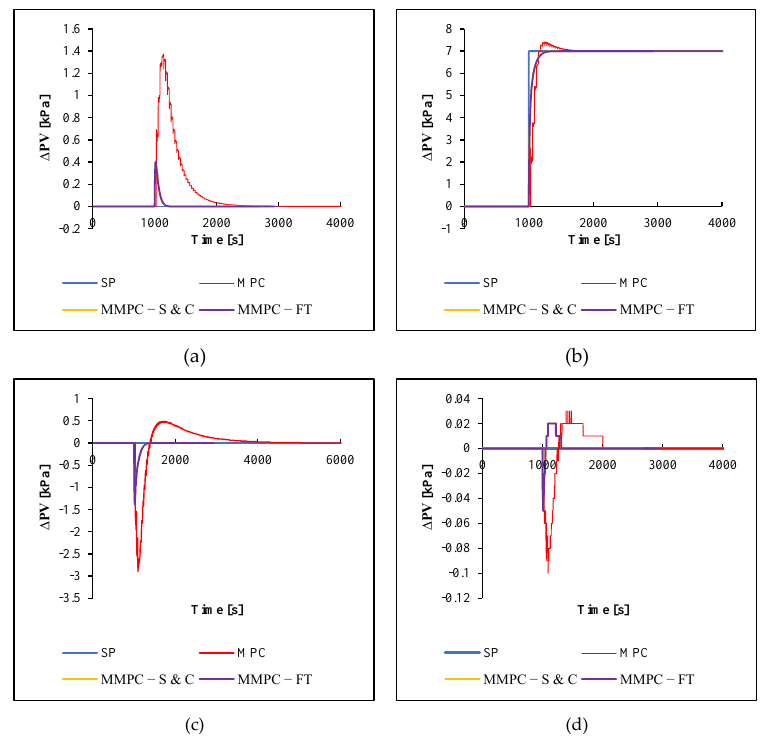
Figure 4. Comparison of controller performance with SP changes on compressor unit 2 (MIMO Model 1) on: ( a ) compressor unit 1; ( b ) compressor unit 2; ( c ) compressor unit 3; and ( d ) compressor unit 4.